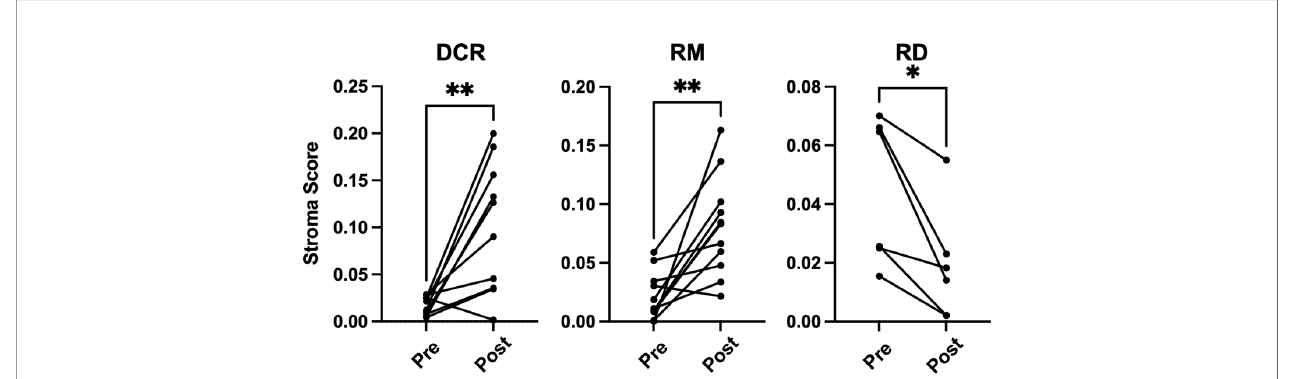
FIGURE 4 | xCell based gene set enrichment analysis shows signi fi cant changes of stroma scores with increasing stromal cells in DCR and RM cases compared to decreasing stromal cells in RD cases. * indicates p < 0.05, ** inidcates p <